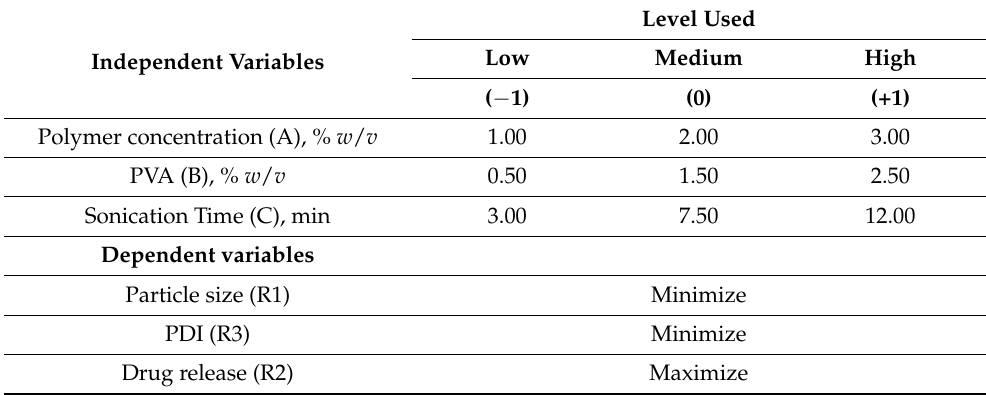
Table 1. Box–Behnken design variables for formulation of Dox–Erlo NPs.